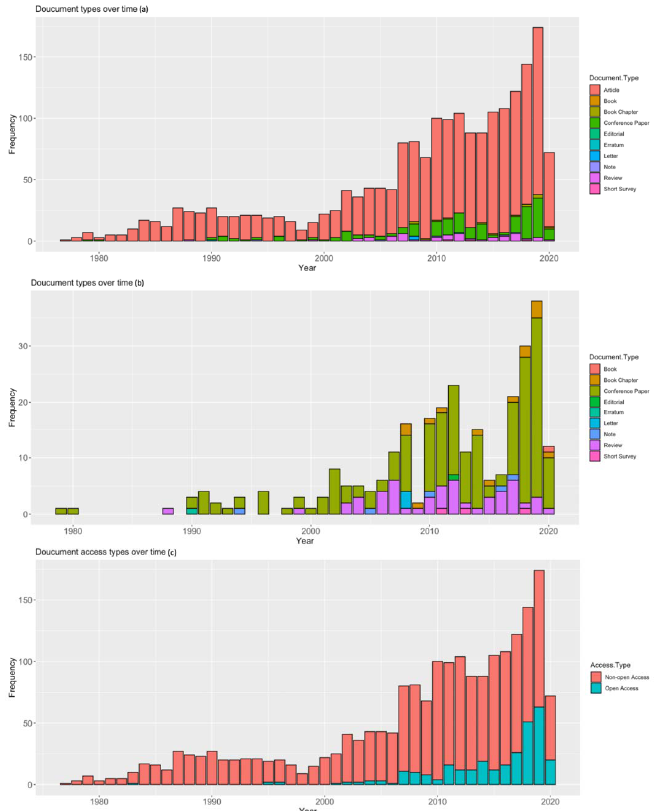
Figure 1. ( a ) Number of publications types, ( b ) number of publications types excluding the type “article”, and ( c ) access types of publication possessing an association with water hyacinth